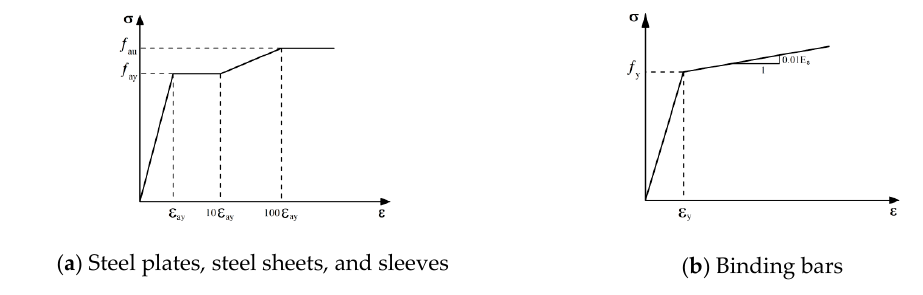
Figure 7. Stress-strain relationship for steel .